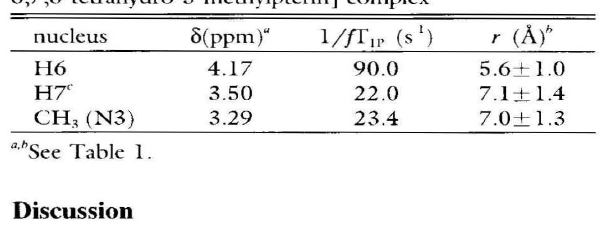
Table 3. Calculated distances /Tom Co(II) to protons of 5,6,7,8-tetrahydro-3-methylpterin in the [TH1-Co(II) 5, 6,7 ,8-tetrahydro-3-methylpterin]